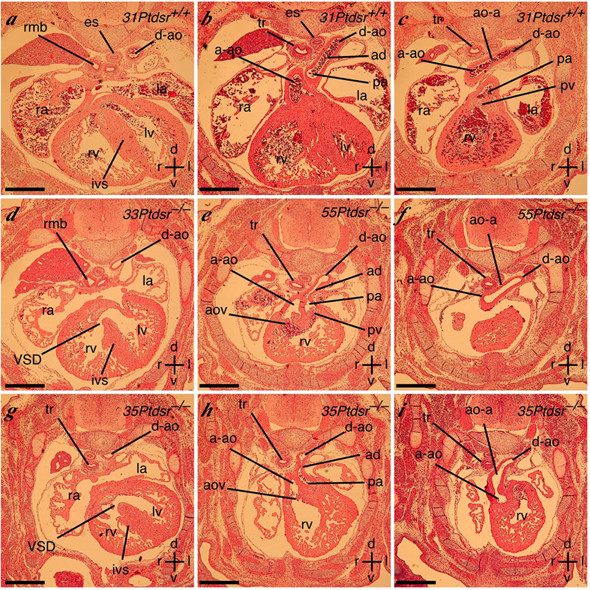
Cardiac malformations in Ptdsr-/- embryos: analysis using histology Embryos analyzed by MRI (Figure 3) were sectioned transversely and stained with hematoxylin and eosin. (a–c) Serial caudal to cranial sections of the wild-type embryo showing normal cardiac and vascular anatomy. The left and right ventricles (lv, rv) are separated by the interventricular septum (ivs). The ascending aorta (a-ao) arises from the left ventricle, continues on as the aortic arch (ao-a), which joins the descending aorta (d-ao). The pulmonary artery (pa) arises from the right ventricle via the pulmonary valve (pv) and continues as the arterial duct (ad), which joins the descending aorta. The left and right atria (la, ra), trachea (tr), right main bronchus (rmb) and esophagus (es) are indicated. (d) Section through embryo 33 indicating the ventricular septal defect (VSD). (e, f) Sections through embryo 55 showing that both aorta and pulmonary artery arise from the right ventricle (double outlet right ventricle), and that the arterial duct of the pulmonary artery is narrow in comparison to the aorta – indicating pulmonary artery hypoplasia. The aortic valve (aov) is indicated. (g–i) Serial caudal to cranial sections through embryo 35 showing a VSD, aorta arising from the right ventricle (double outlet right ventricle), and a severely narrowed arterial duct. Scale bars = 500 μm; axes: r – right; l – left; d – dorsal; v – ventral. Individual embryos are indicated by number.